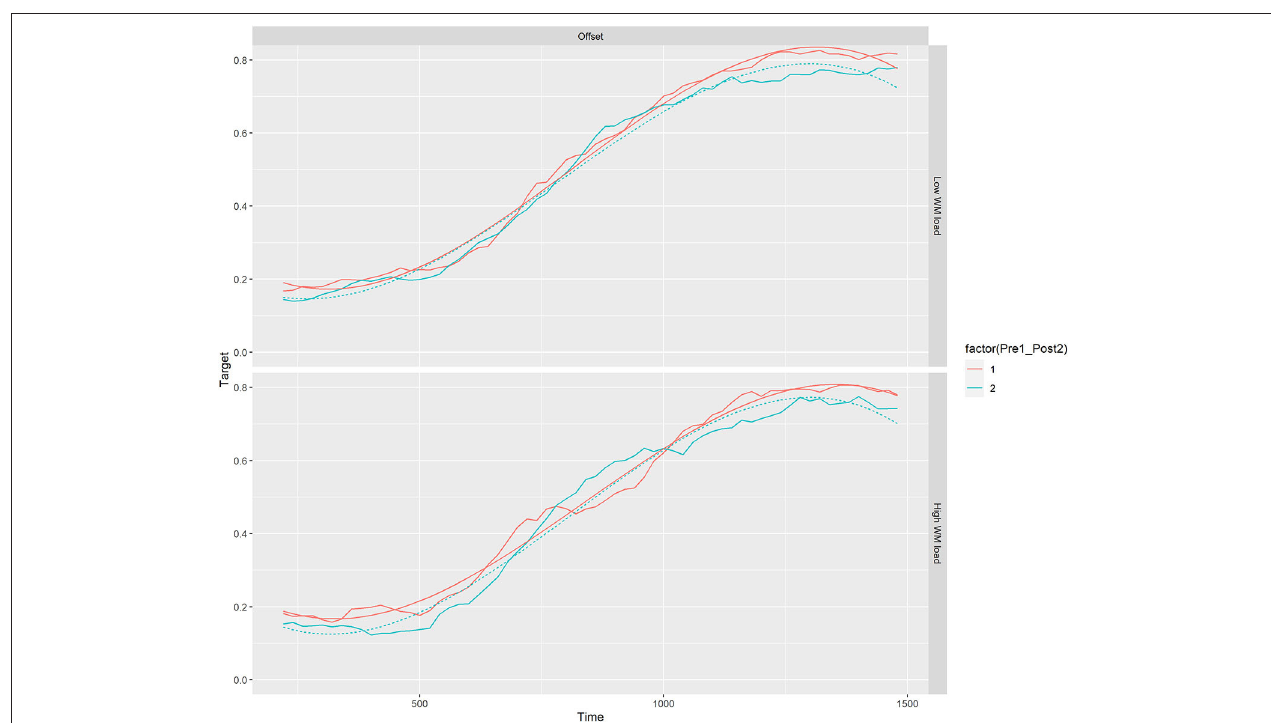
FIGURE 1 | Mean proportion of fixations to the target for older adults in the offset competitor condition compared across test-session 1 and 2 according to low (1 digit) or high (4 digit) working memory preload. The red line indicates test-session 1 and the blue line indicates test-session 2 following a 2 week interval. The model fits (smooth lines) are plotted along with the observed target fixation